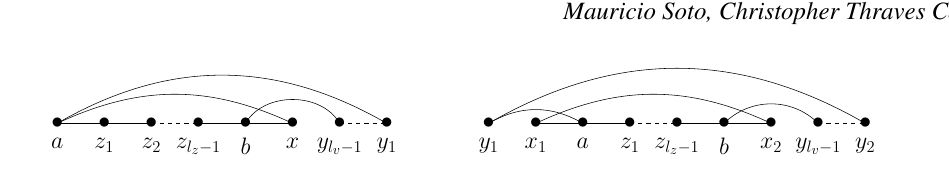
Fig. 7: This figure shows a graphic representation of H 2 ,l y ,l z and H 3 ,l y ,l z where the order of the vertices satisfies the four point